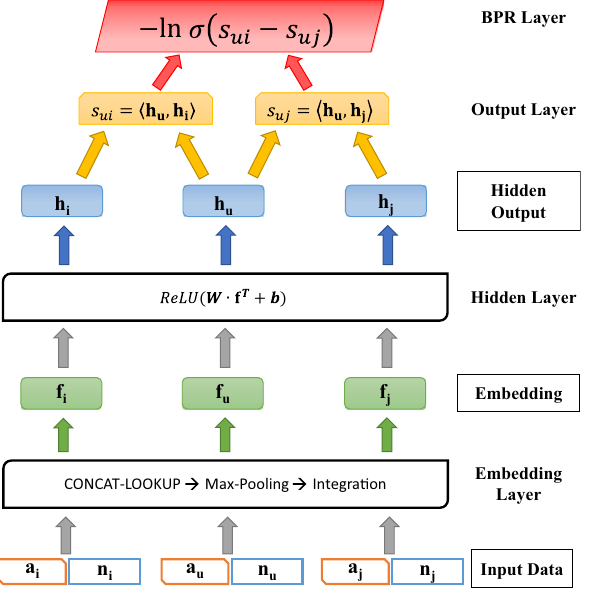
Fig. 2 Mechanism of the embedding layer for the vertex b of a toy attributed graph. The graph contains 5 vertices and 6 edges, where each vertex is associated with a collection of nodal attributes. For example, vertex b is connected to vertices { a , c , d } and associated with attributes { x 2 , x 6 } , respectively. The cardinality of the attribute ⋯ , x set { x 1 , 7 } is